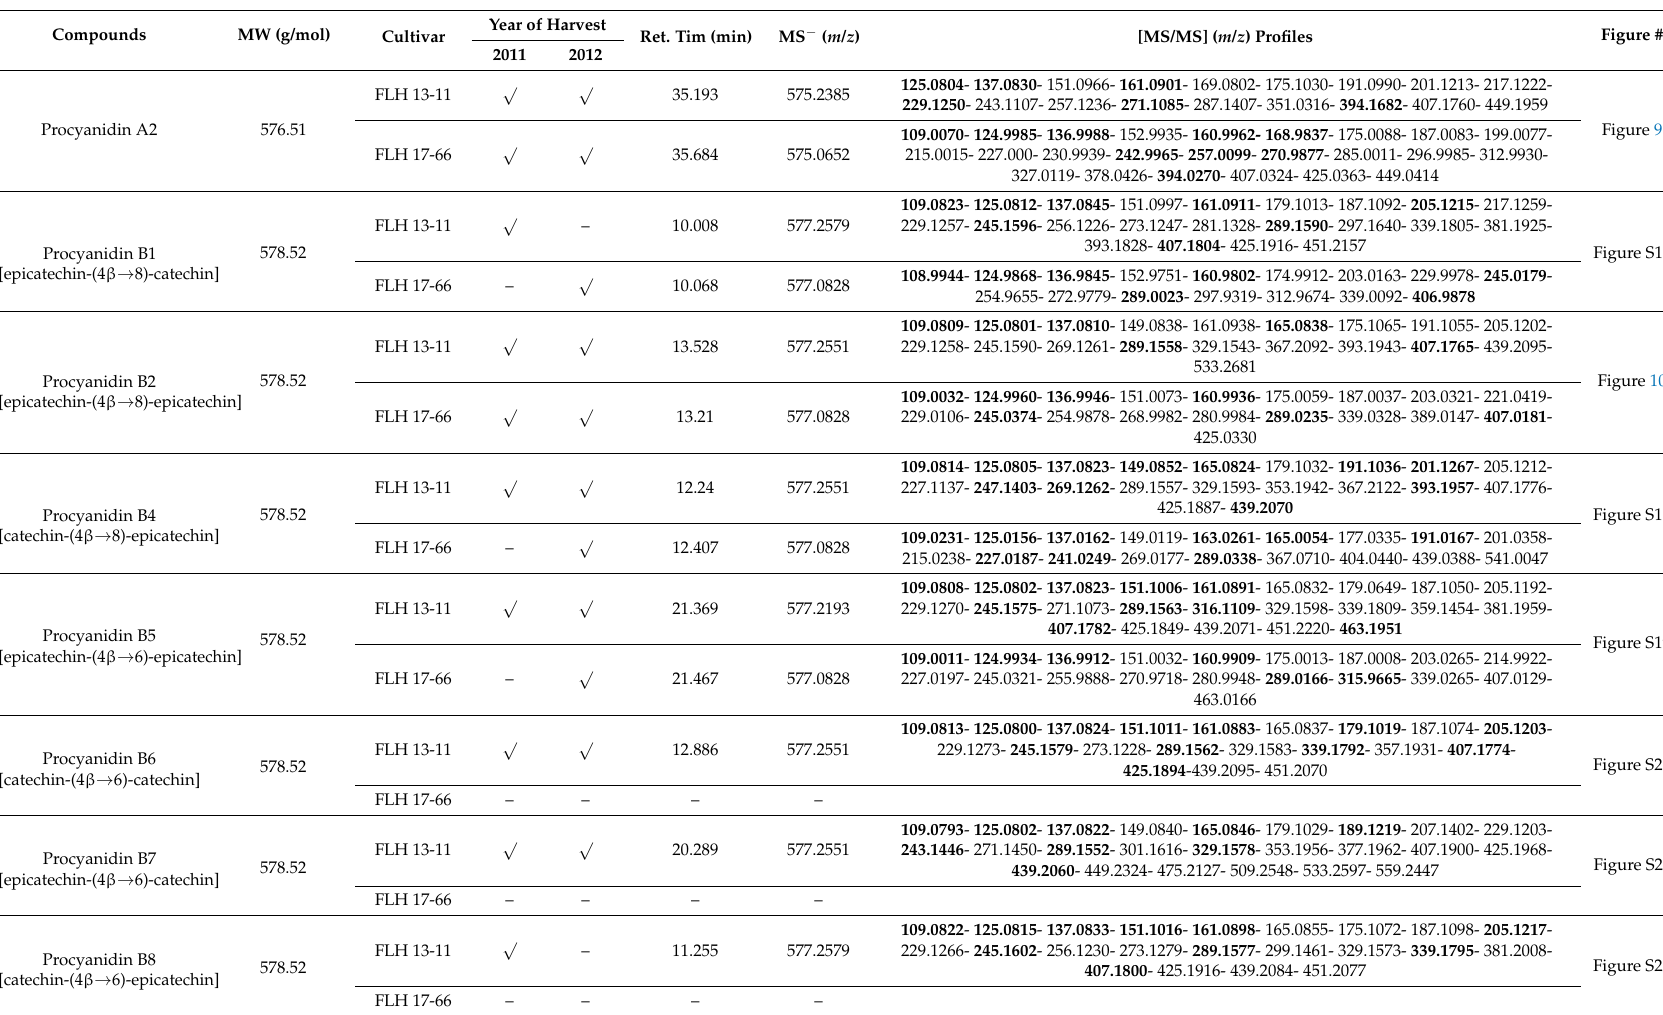
Table 4. Eight dimeric proanthocyanidins were detected in berries of two interspecific hybrid cultivars FLH 13-11 and FLH 17-66. (Note: “–” means not detected).